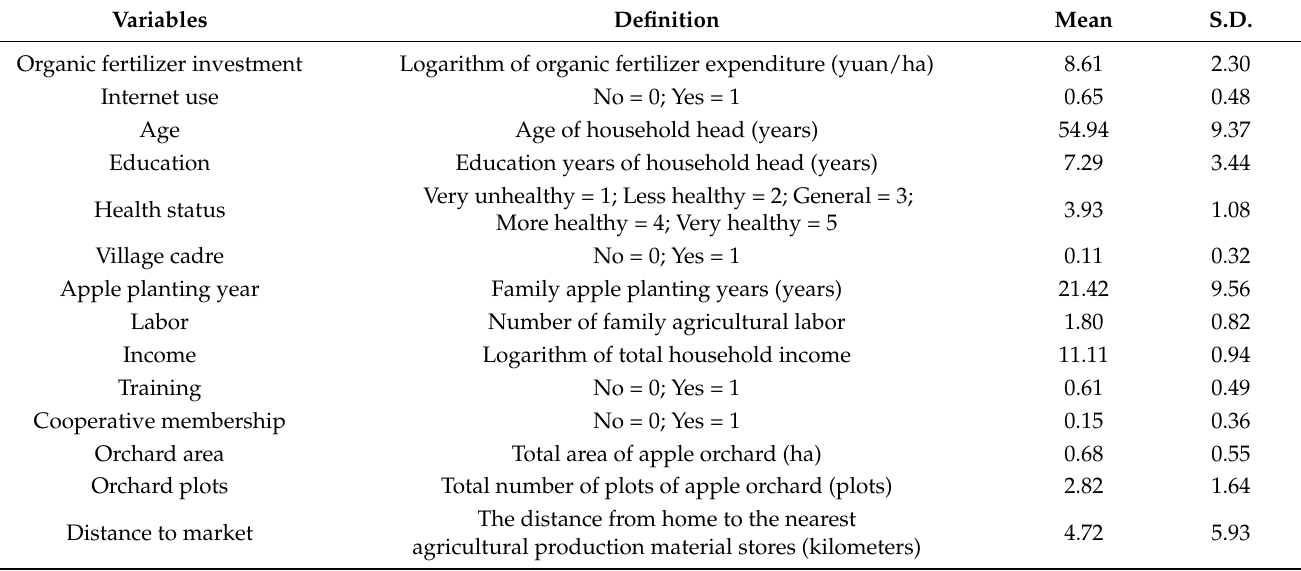
Table 1. Variable definition and statistical